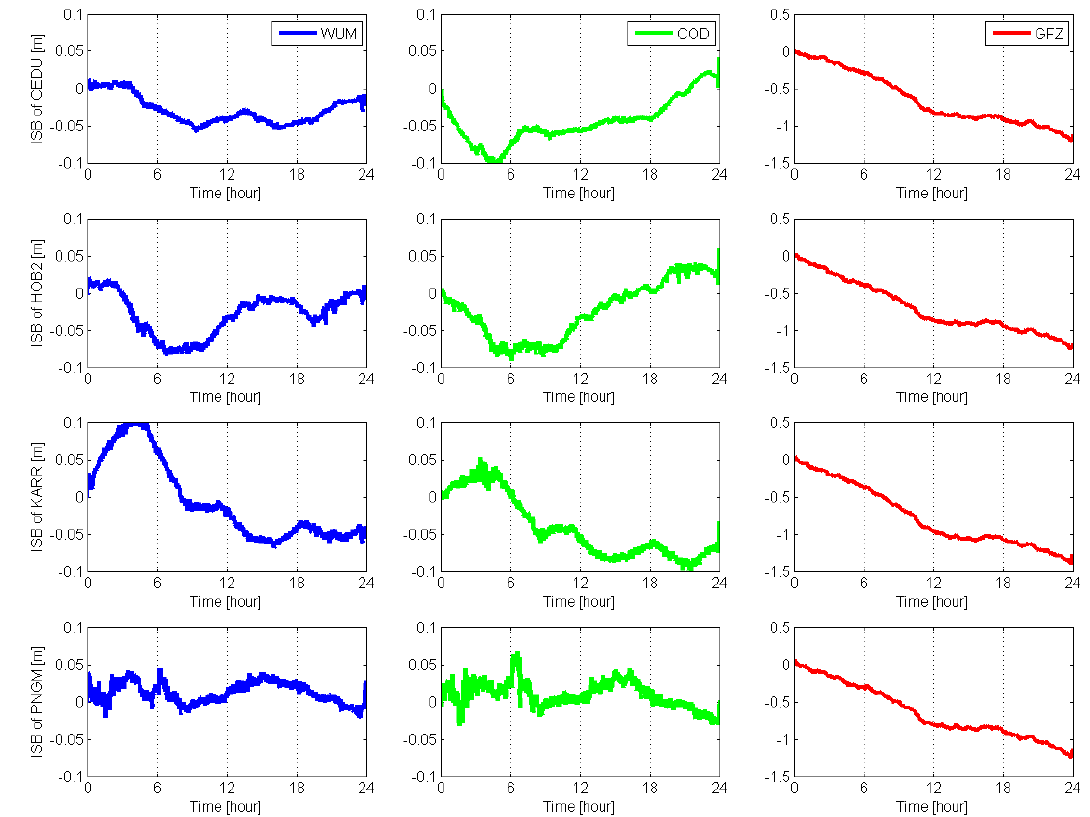
Figure 3. GPS / BDS ISB series of CEDU / HOB2 / KARR and PNGM stations estimated using WHU, Figure 3. GPS/BDS ISB series of CEDU/HOB2/KARR and PNGM stations estimated using WHU, CODE and GFZ precise products on DOY 002, 2018. CODE and GFZ precise products on DOY 002, 2018.